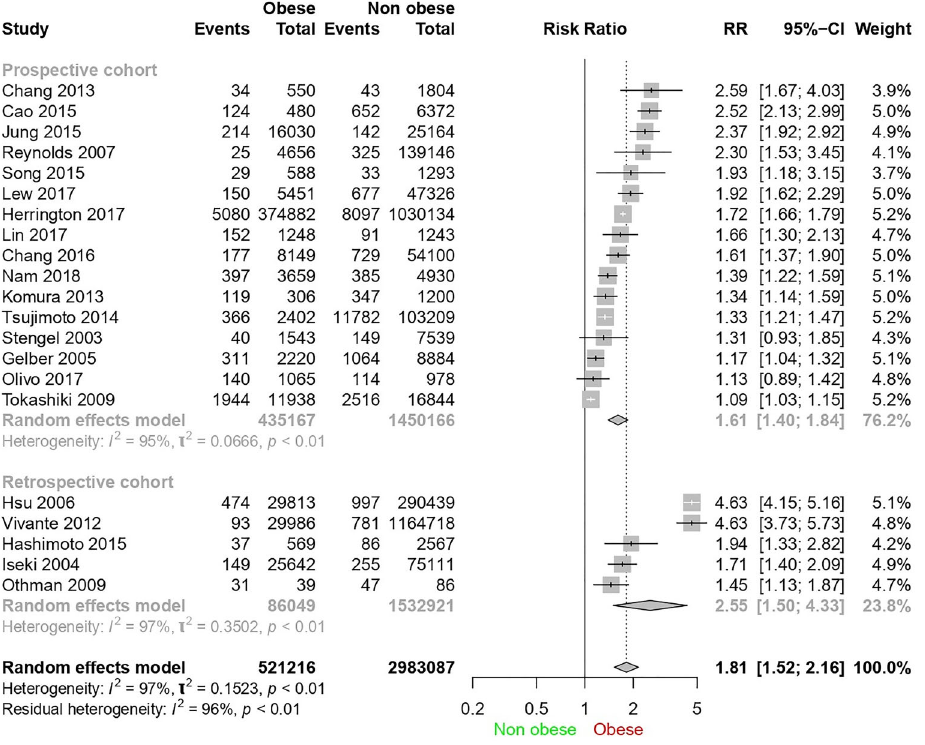
Figure 4. Forest plot for sensitivity analysis according to study